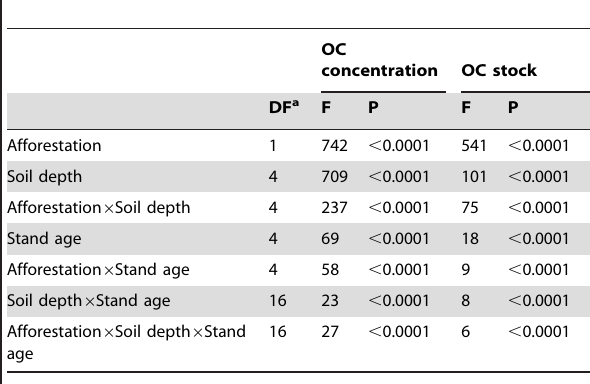
Table 2. The ANOVA results of soil OC concentration and OC stock as affected by afforestation, stand age, and soil